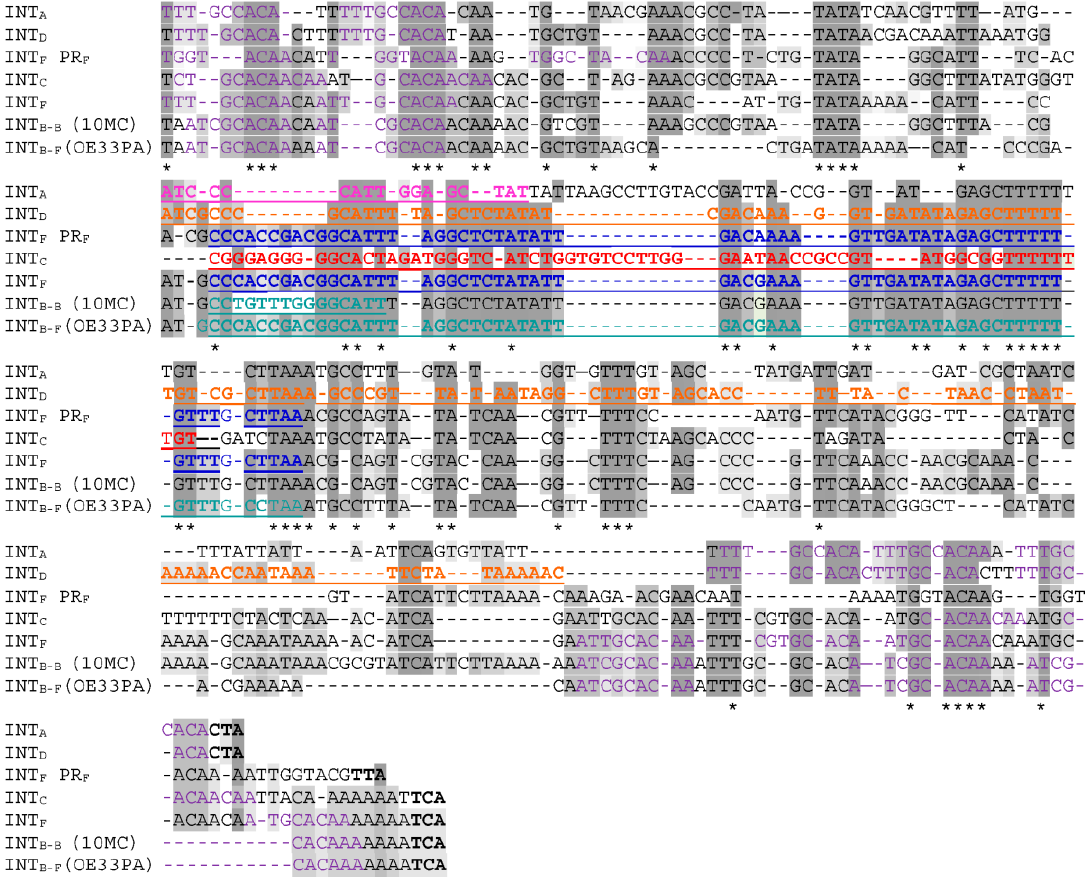
Figure 5. Alignments of the attP sequences found in the different oenophages. The homologous core sequences involved in recombination with the bacterial chromosome are underlined and in color (the color code is the same as shown in Figure 1). All direct repeats serving as putative binding sites for integrases are in purple. The three last nucleotides correspond to the stop codon of the integrase genes. A clustal alignment was first constructed and gaps were introduced manually.